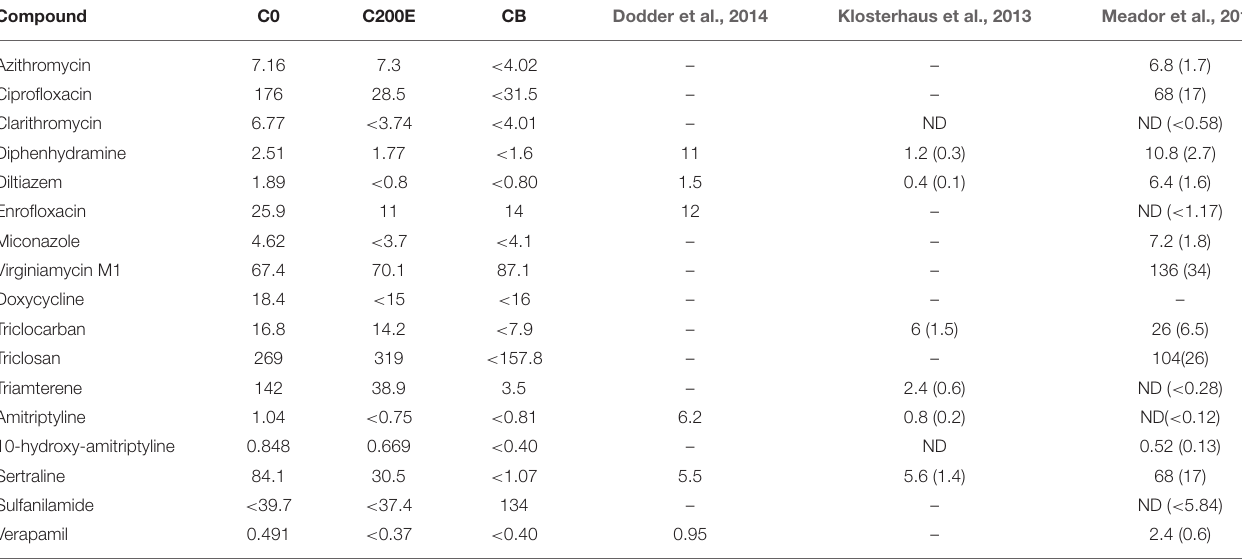
TABLE 6 | Tissue concentrations (single sample results, ng g − 1 dry weight) from Horse Mussels collected near the CLO